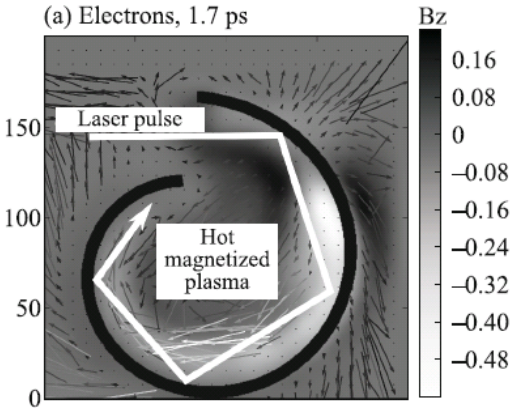
Fig. 2. Spatial distribution of the electron flows and magnetic field at a time of 1.7 ps. The momenta of the electrons are demonstrated by arrows in units of m e c , the strengths of the magnetic field Bz in the direction perpendicular to the figure plane are shown as the background of the figure according to the color scale at the same times.